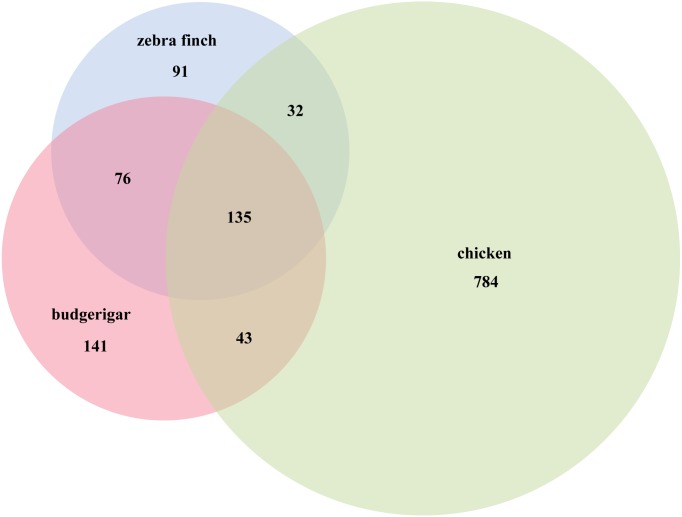
Budgerigar miRNAs compared with zebra finch and chicken in miRBase v21.